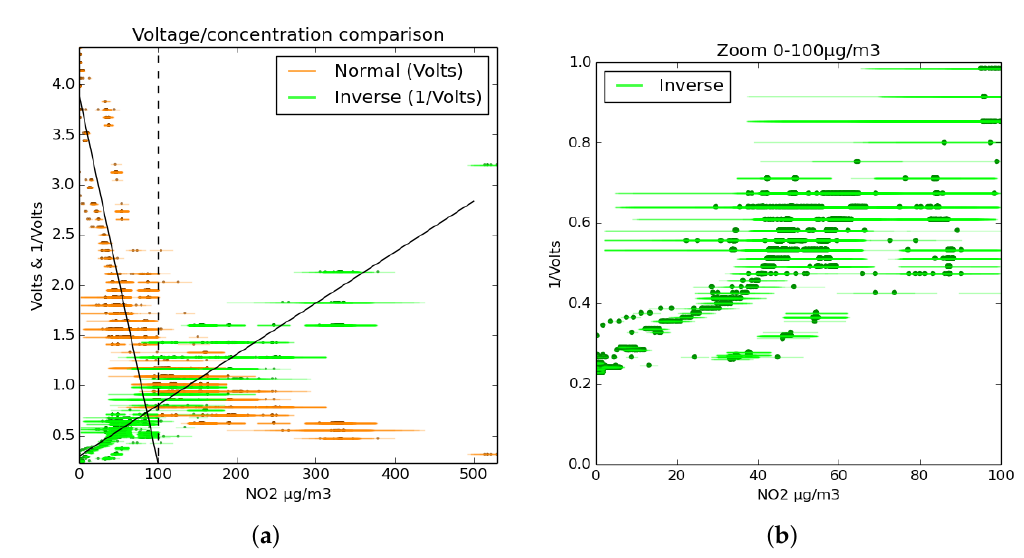
Figure 7. Results from the BBCEAS calibration experiment, showing both the raw output voltage and inverse voltage of the same measurement. The darker points are the data; the horizontal lines are the error ranges of the concentration. The experiment demonstrated sensitivity up to 400µgm − 3 as shown in ( a ). Although at high concentrations, the voltages from the sensors becomes quite low, in most atmospheres, NO does not often surpass 50 ppb. For concentrations less than 100µgm − 3 , 2 both normal and inverse voltage can be seen as approximately linear. Graph ( b ) shows the data for inverse voltage at low